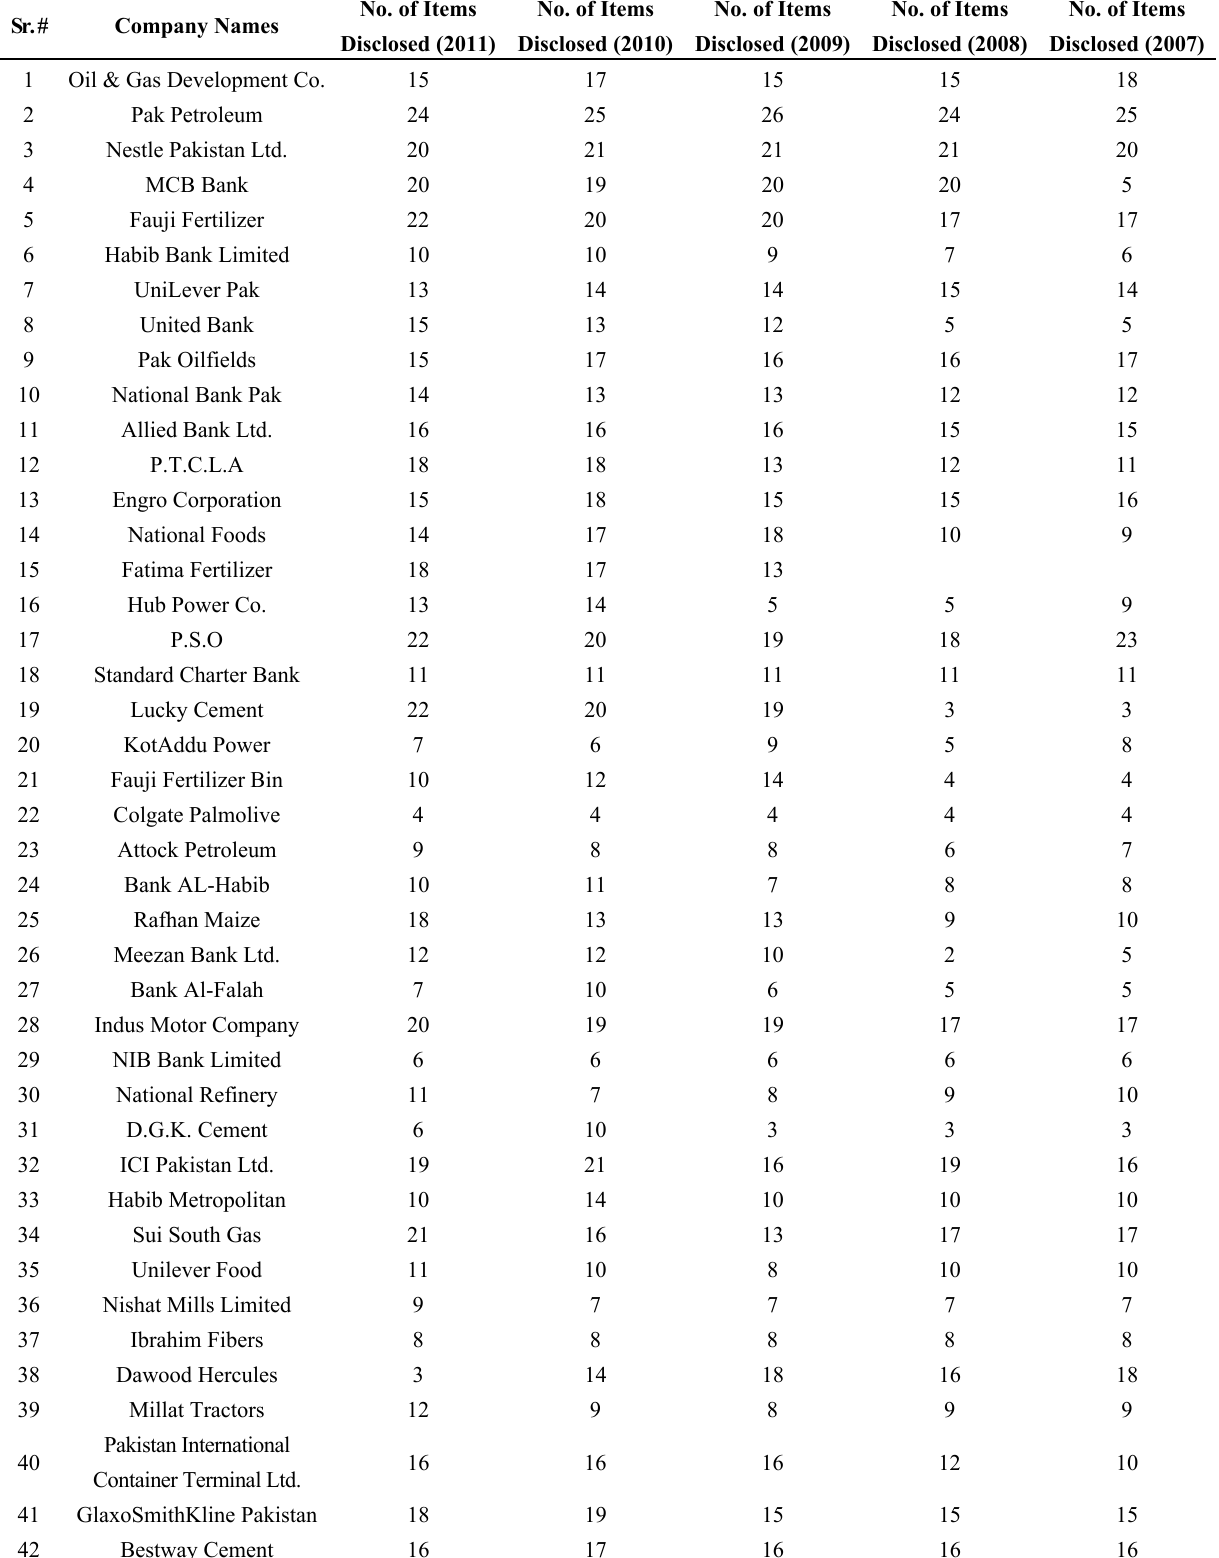
Table A2. List of Companies Included in the Study and Number of CSR Items Disclosed of Each